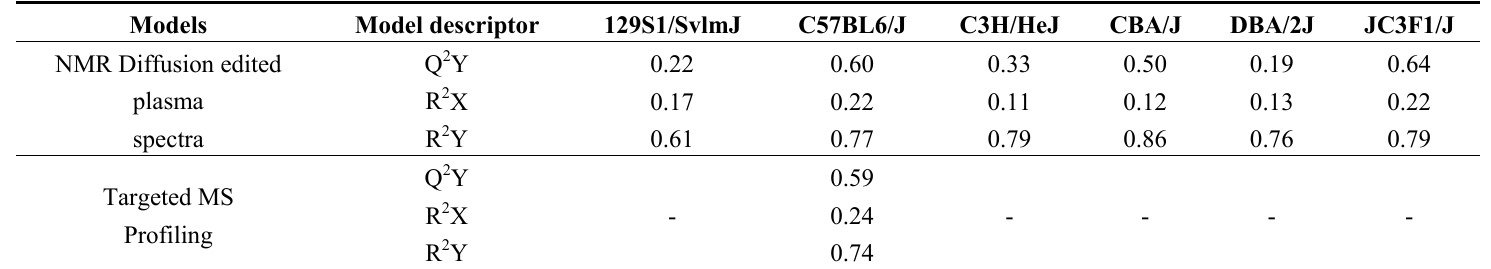
Table A3. O-PLS-DA model summary for discriminating plasma metabolic profiles based on targeted MS profiling and NMR analysis on the six tested animal